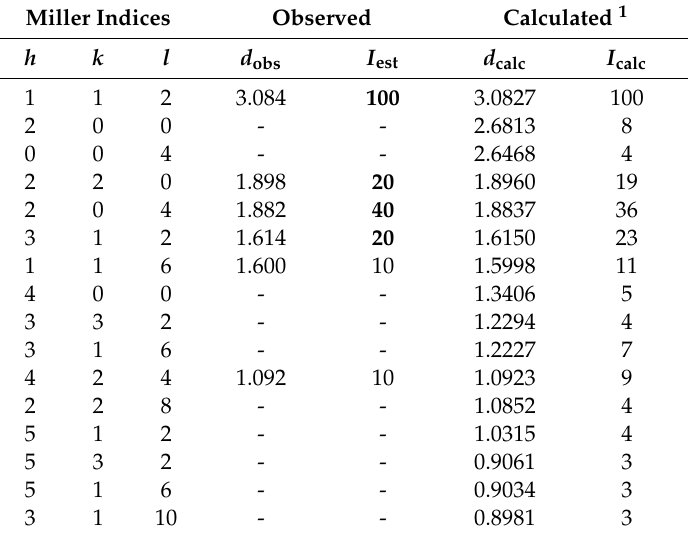
Table 4. Observed and calculated 1 X-ray powder di ff raction data ( d -spacings in Å) for richardsite. The strongest four estimated relative intensities I are given in bold